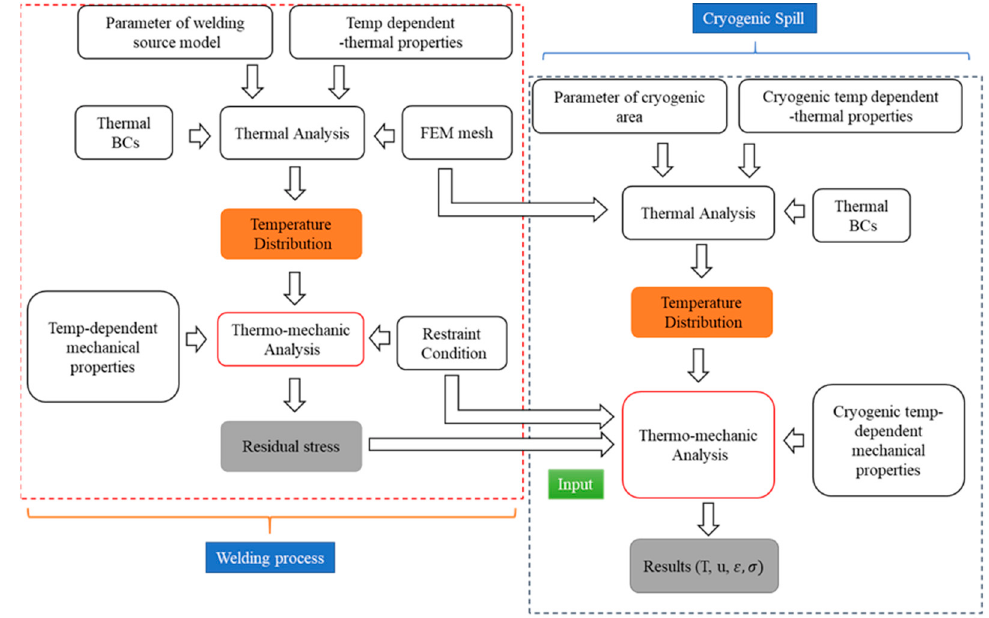
Figure 6. Flow chart of the procedure for the FE calculation.